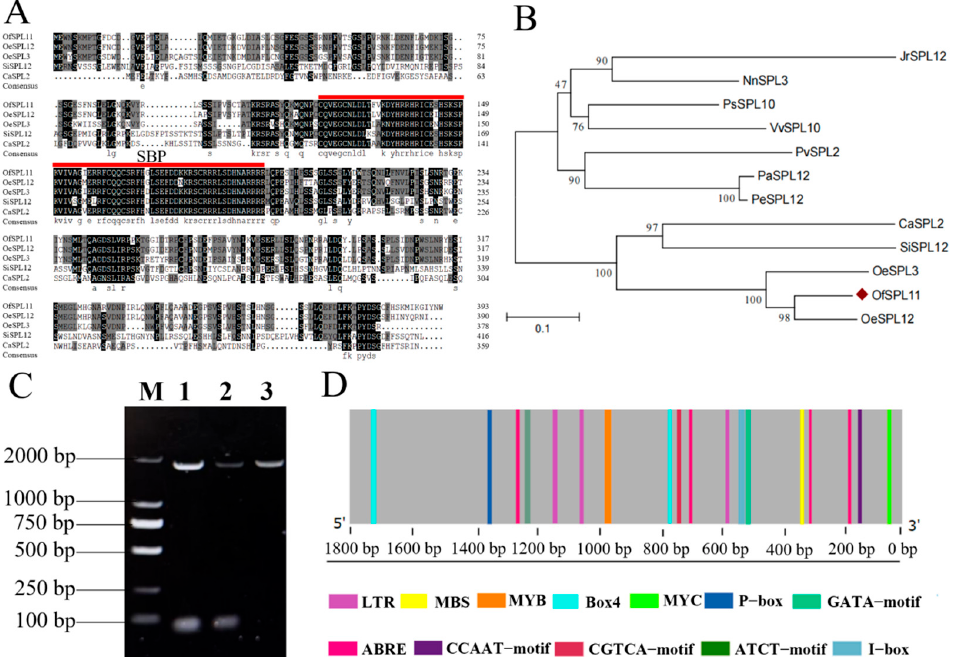
Figure 2. Multiple sequence alignment, phylogenetic analysis, and promoter cis-acting element analysis of OfSPL11 . ( A ) OfSPL11 and homologous gene amino acid sequence comparison. Black represents identical amino acids, gray represents similar amino acids. Conserved structural domains of SBP have been underlined in red; ( B ) phylogenetic tree of OfSPL11 and homologous genes. Detailed information is as follows: Osmanthus fragrans , OfSPL11, QTM66379.1; Olea europaea, OlSPL12 ,